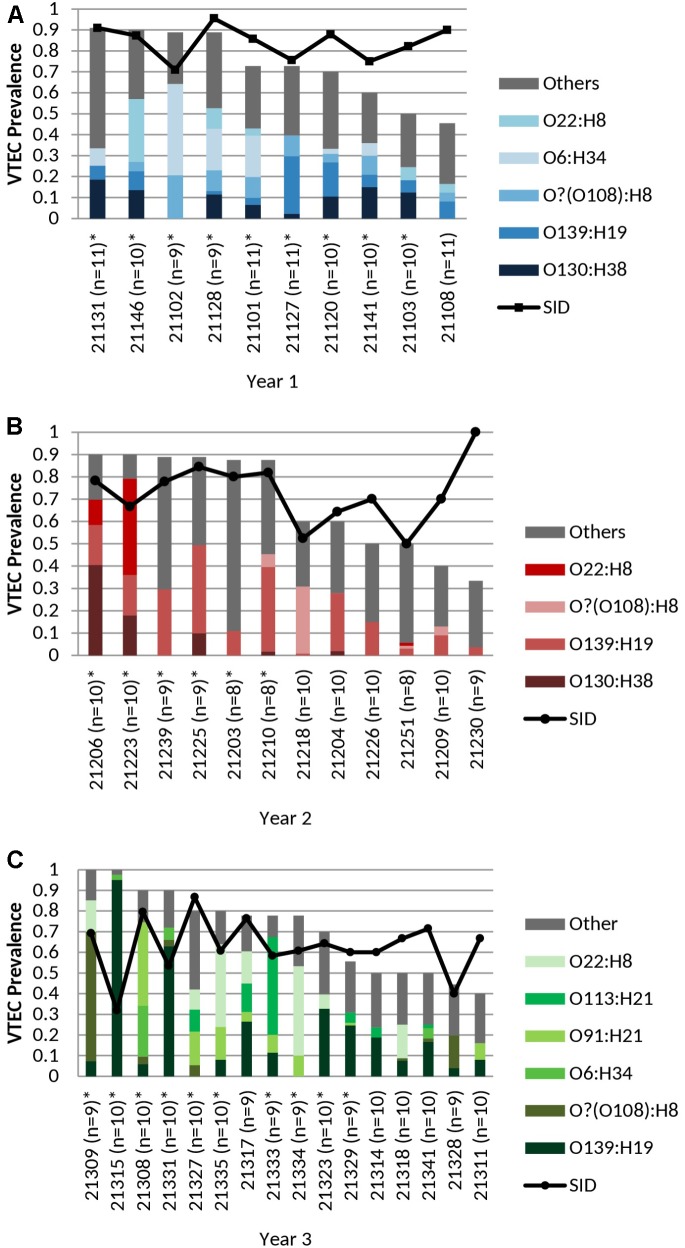
(A) Cohort-year 1, (B) Cohort-year 2, and (C) Cohort-year 3. Cohort-specific VTEC prevalence, serotype distribution, serotype diversity (SID) and persistent shedding in heifers. n = no. of samples per animal. Line: Simpson’s Index of Diversity (SID), where 0 = no diversity, 1 = infinite diversity. ∗ Persistent shedder (Menrath et al., 2010) (at least half and ≥4 consecutive vt positive samples). Bar (total): isolation rate. Bar (stacked colors): serotype distribution of top serotypes (≥5 samples per year). No. of samples: cohort-year 1 (n = 103), cohort-year 2 (n = 111), and cohort-year 3 (n = 154). No. of isolates: cohort-year 1 (n = 277), cohort-year 2 (n = 283), and cohort-year 3 (n = 388). VTEC isolation rates (total) were not statistically different (p ≥ 0.05) between individual heifers. Average per-animal VTEC prevalence (isolation) rate: 70.5% (Overall), 72.1% (Year 1), 68.8% (Year 2), 70.8% (Year 3). Average per-animal SID values: 0.72 (Overall), 0.84 (Year 1), 0.73 (Year 2), 0.63 (Year 3).